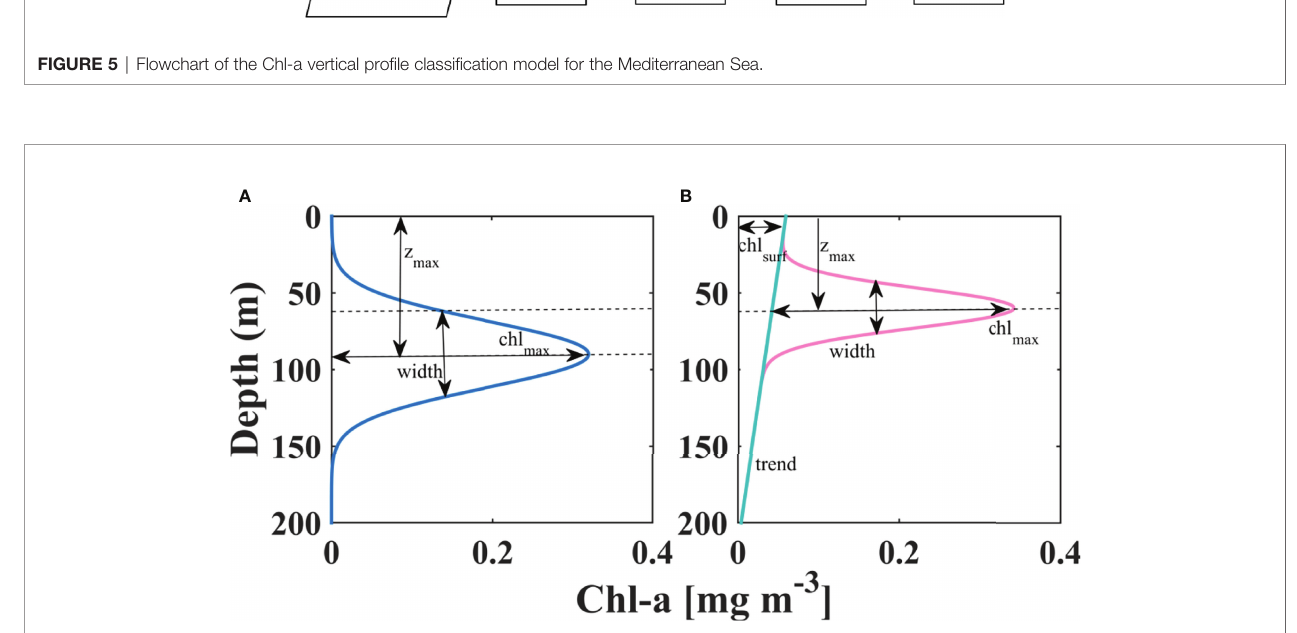
FIGURE 6 | Shape difference between the generalized (A) and modi fi ed Gaussian (B)